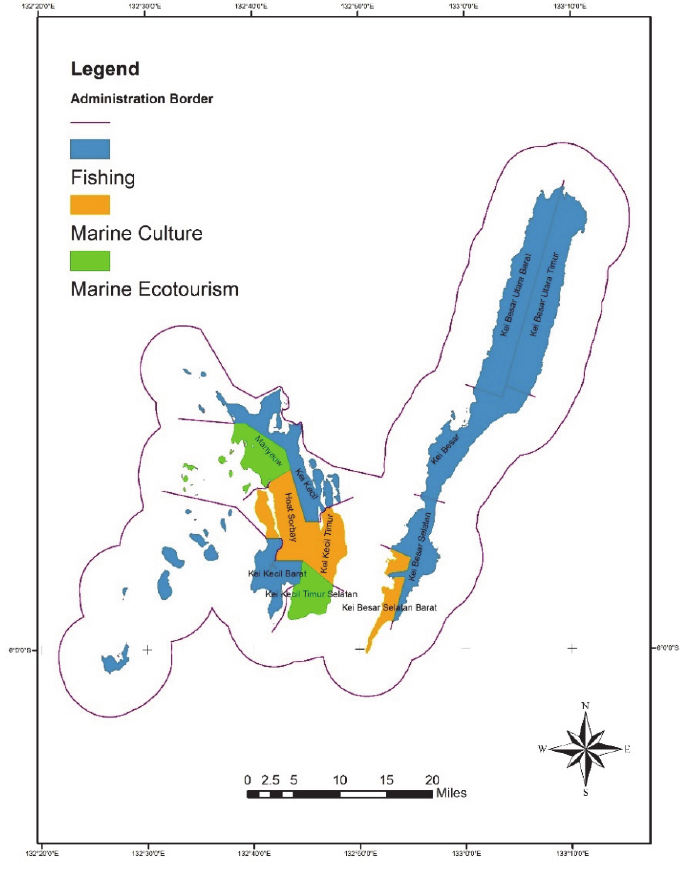
Fig. 4. Mapping Top Fisheries Sub-sectors in Southeast Maluku